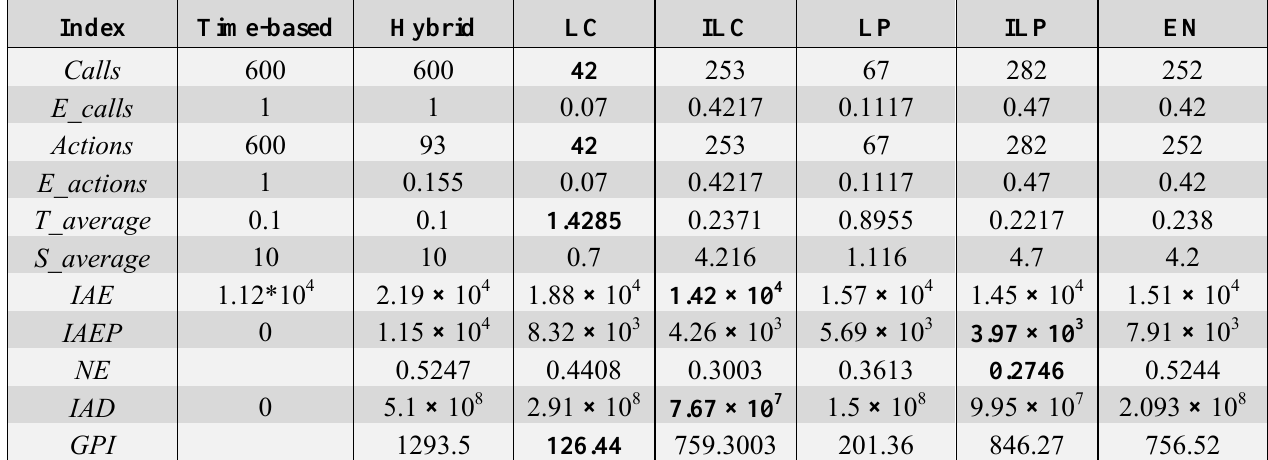
Table 6. Performance indexes of the hybrid and event-based approaches for  Figures in bold represent the best value of every performance index in the hybrid and event-based